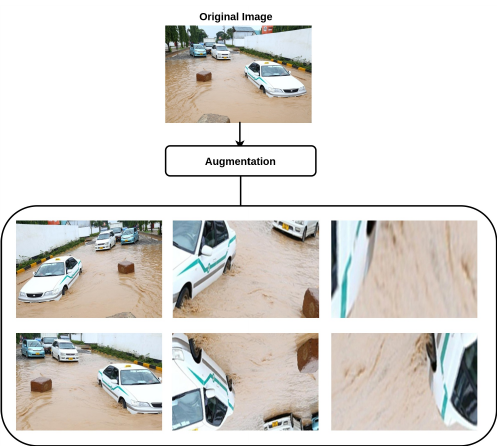
Figure 8. Different augmented samples created from single image.